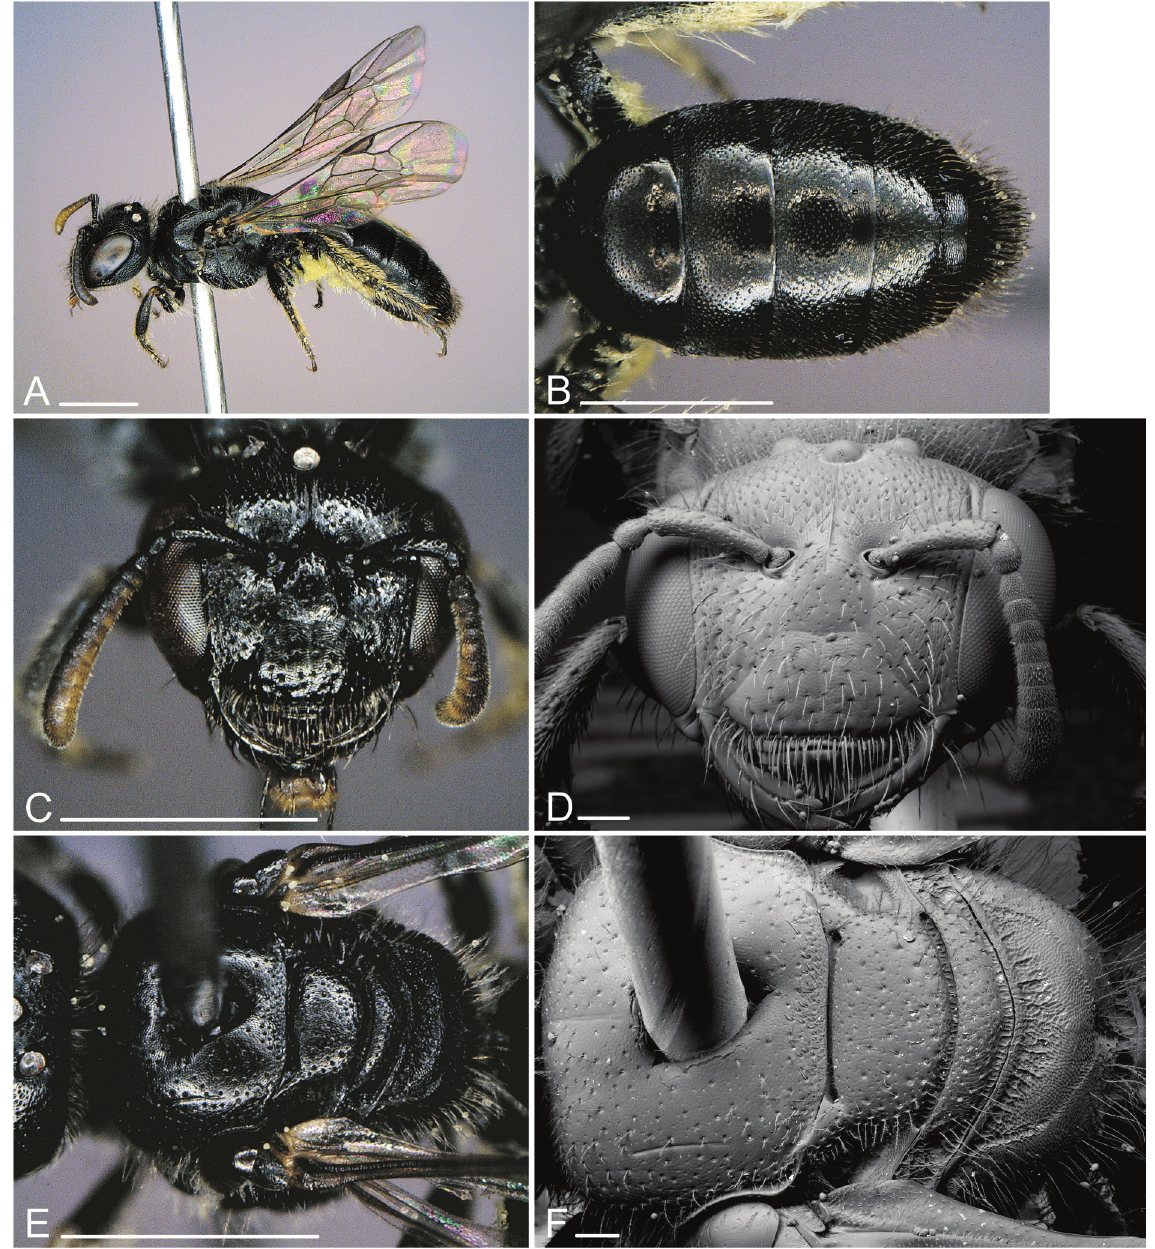
Fig. 16. Scrapter nanus sp. nov., ♀. A . Lateral view. B . Metasoma (dorsal view). C . Head. D . Head (SEM). E . Thorax (dorsal view). F . Thorax (dorsal view, SEM). Scale bars: photos: 1 mm, SEM: